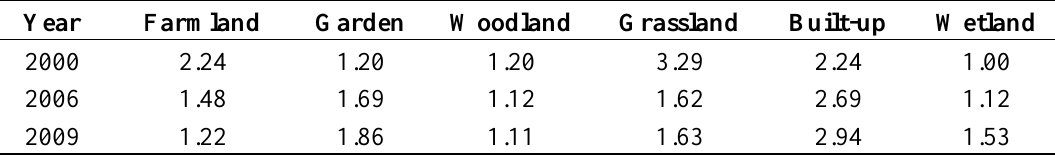
Table 6. Supply distribution coefficients for different land-use covers.